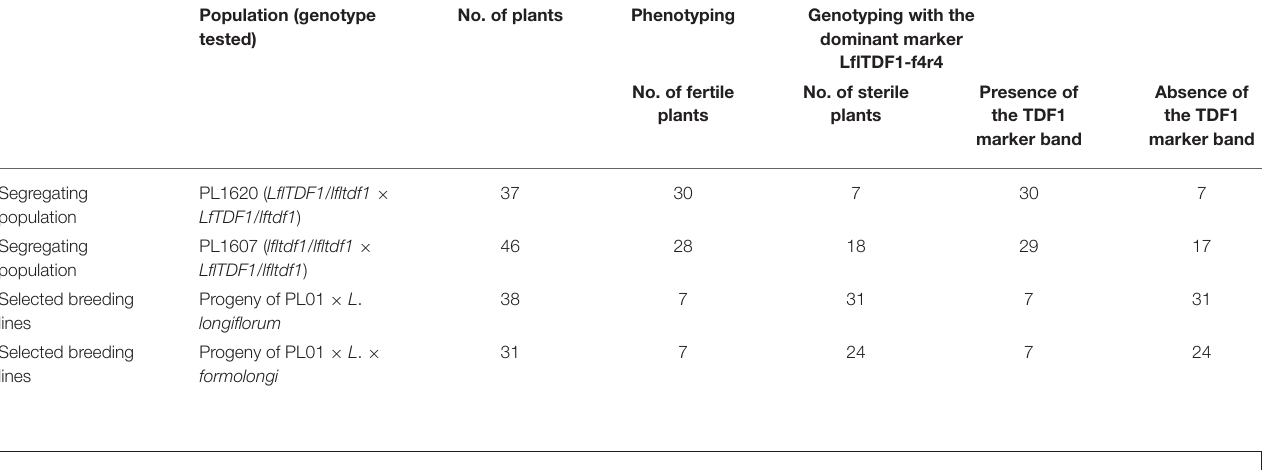
FIGURE 4 | population (26–47). Unigene (15801) primer pair was used for a positive control. (D) Phylogenic relationships of TDF1 orthologs in L . × formolongi ( LflTDF1 ), L. formosanum ( LfsTDF1 ), L. longiflorum cv. Hinomoto ( LlTDF1 ), L . spp. Oriental hybrid cv. Siberia ( LohTDF1 ), Oryza rufipogon ( OrTDF1, ORUFI03G1 4500.1), and A. thaliana ( AtTDF1 , AT3G28470.1). The phylogenetic tree was inferred by using the maximum likelihood method added to MEGA 7.